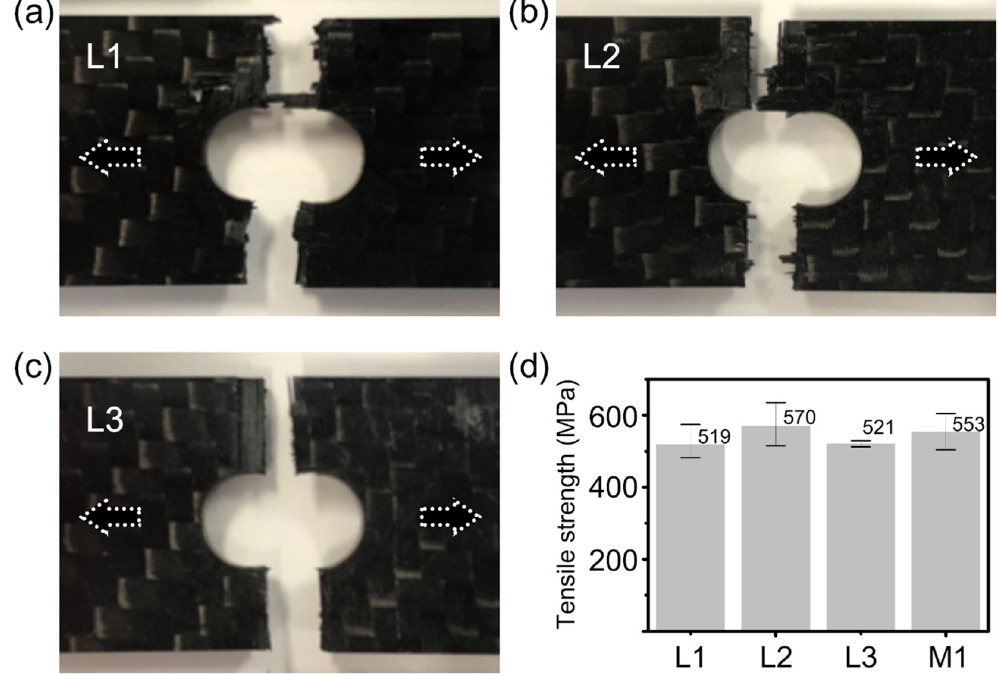
Figure 12. Tensile strength tests of 2.15 mm thickness specimens. The results of tensile strength tests for the specimens, prepared by three different experimental conditions, correspond to ( a ) L1, ( b ) L2, and ( c ) L3, respectively. Each hole diameter = 7 mm. ( d ) Comparison data of tensile strength for picosecond laser processing (L1, L2, and L3) and mechanical drilling processing (M1).